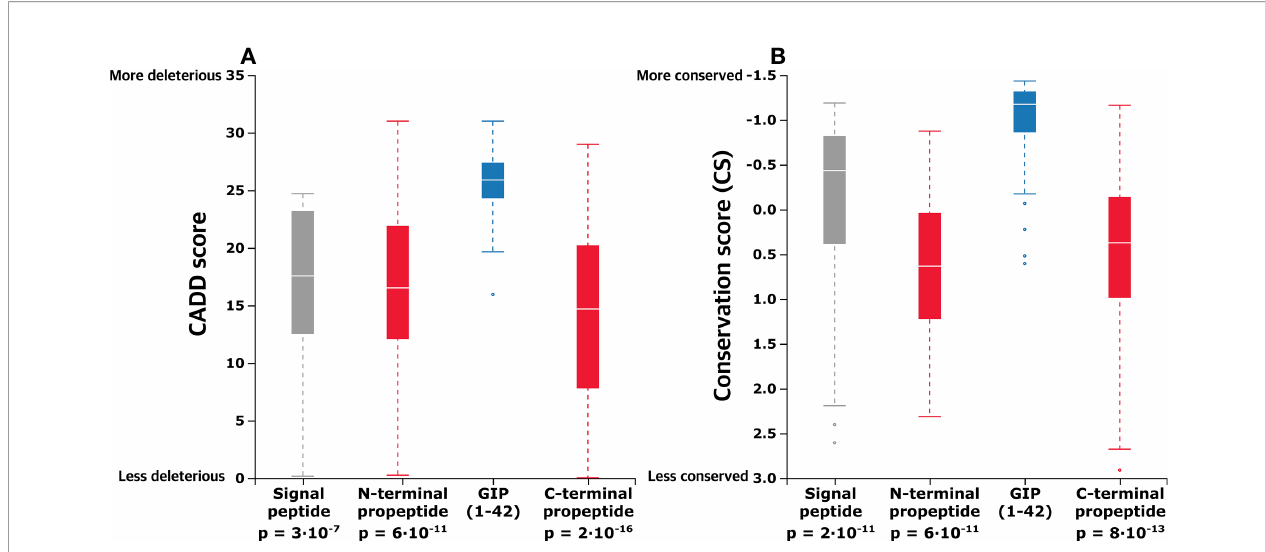
FIGURE 3 | In the proGIP gene, the coding region of the biologically active peptide is more conserved, and missense variants here are more deleterious. (A) Aggregated mean CADD scores (abbreviation of Combined Annotation-Dependent Depletion, predicting variant deleteriousness) for individual pre-pro-GIP regions demonstrate that variants in the GIP sequence exhibit a signi fi cantly higher mean CADD score than those of the other peptide regions. (B) Comparison of aggregated mean conservation scores (CS) indicates stronger evolutionary conservation relative to the other regions of the GIP gene central lines indicates median. Statistical signi fi cance between samples was assessed using the Mann-Whitney U